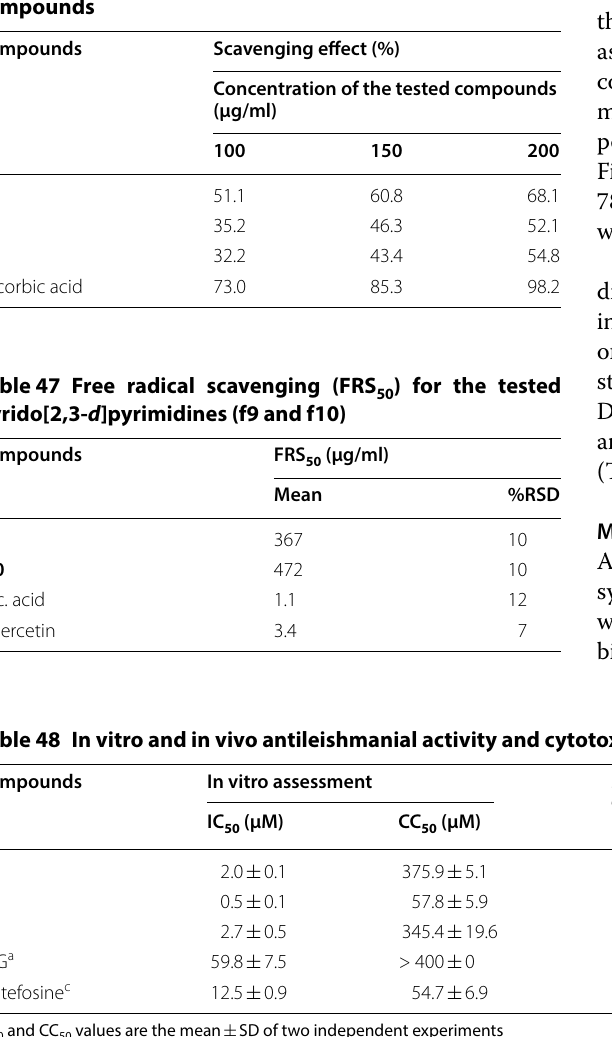
SD of two independent experiments ±